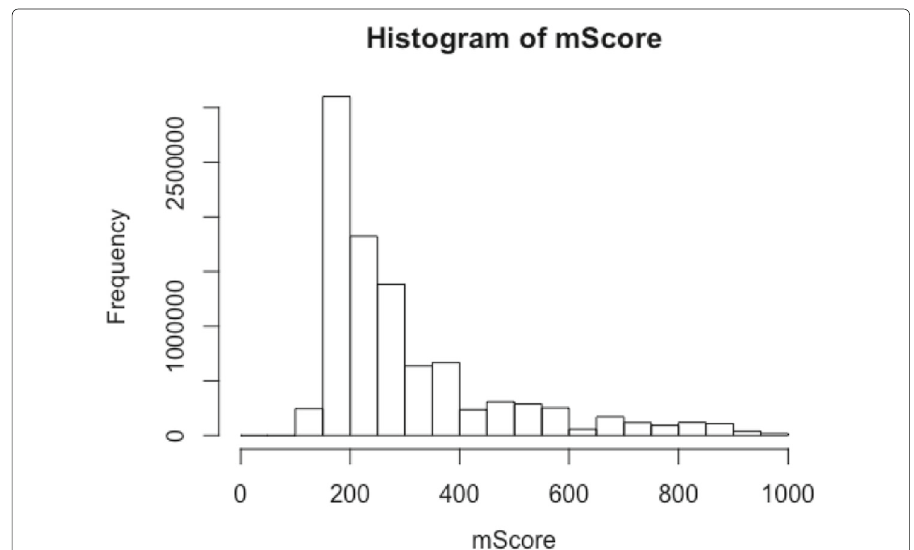
Fig. 11 The distribution of the combined score extracted from the open STITCH data base